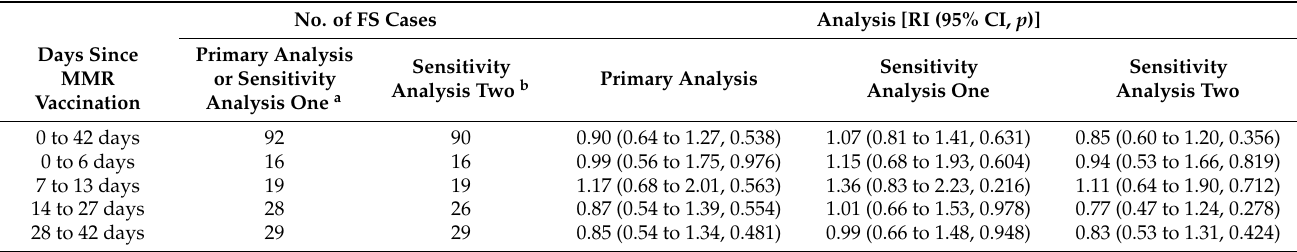
Table 3. Relative incidence of FSs after MMR vaccination.